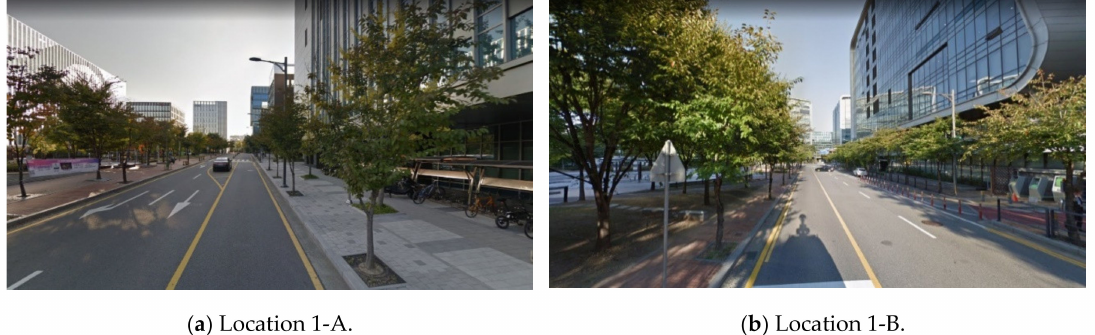
Figure 13. VPD di ff erence according to the tree density (Naver Maps